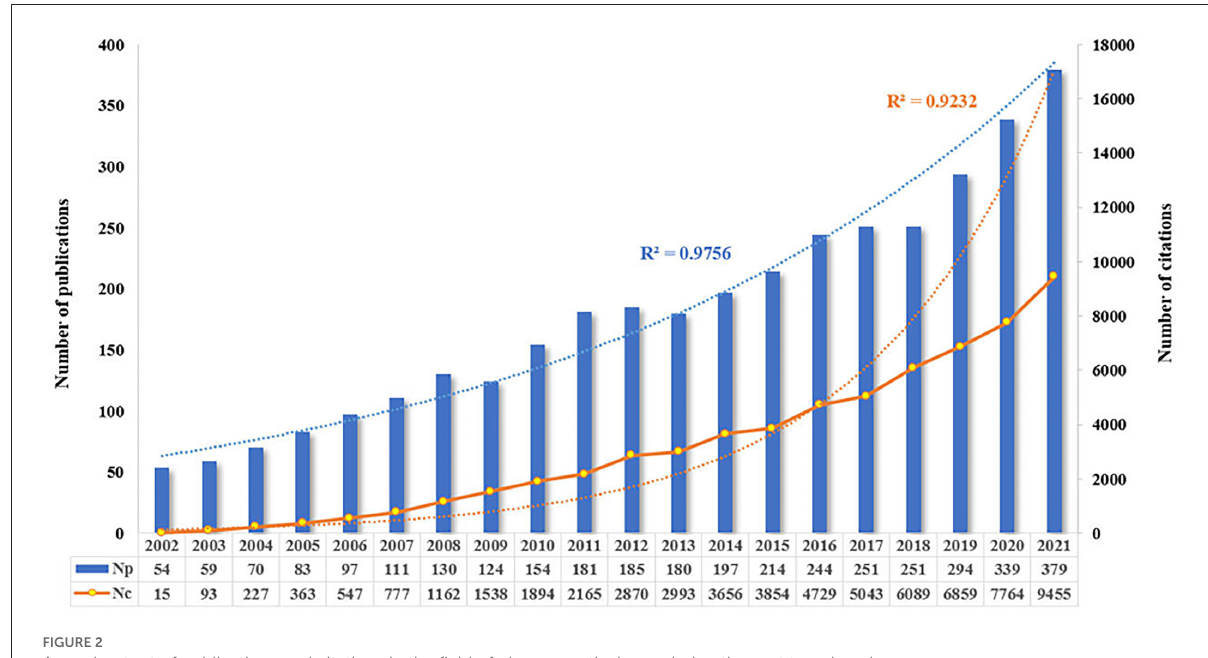
FIGURE2 Annual output of publications and citations in the field of pharmaceutical care during the past two